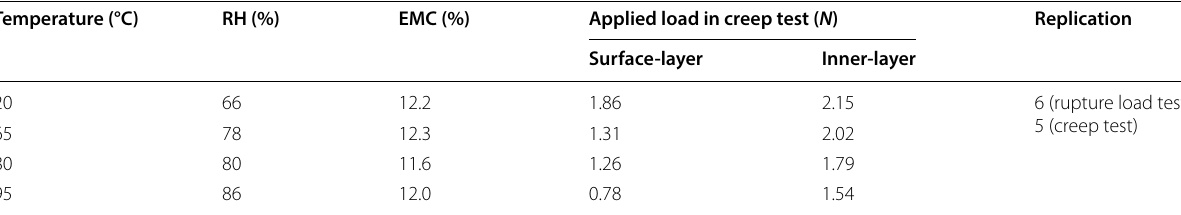
Table 1 Test conditions and applied load in creep test Temperature